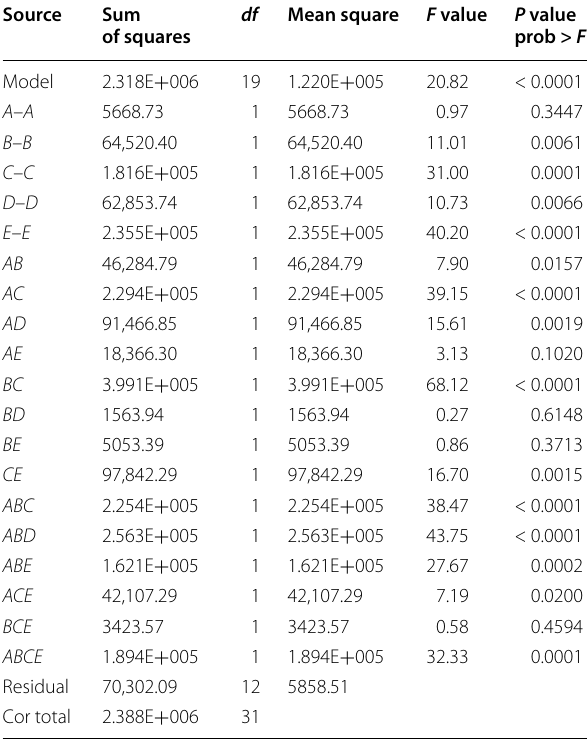
Table 3 Analysis of variance (ANOVA) for amylase yield by 2 5 factorial design